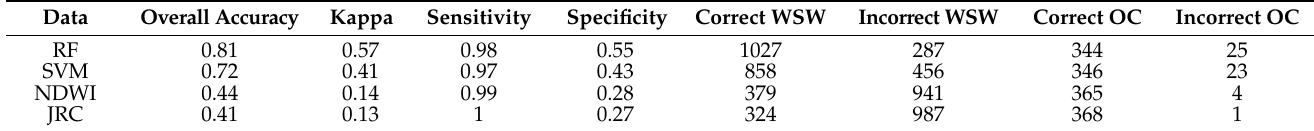
Table 7. Accuracy assessment for detection of wetland surface water (WSW) vs. other classes in small (<850 m 2 ) and non-vegetated (vegetation < 40%) wetlands for 2016.